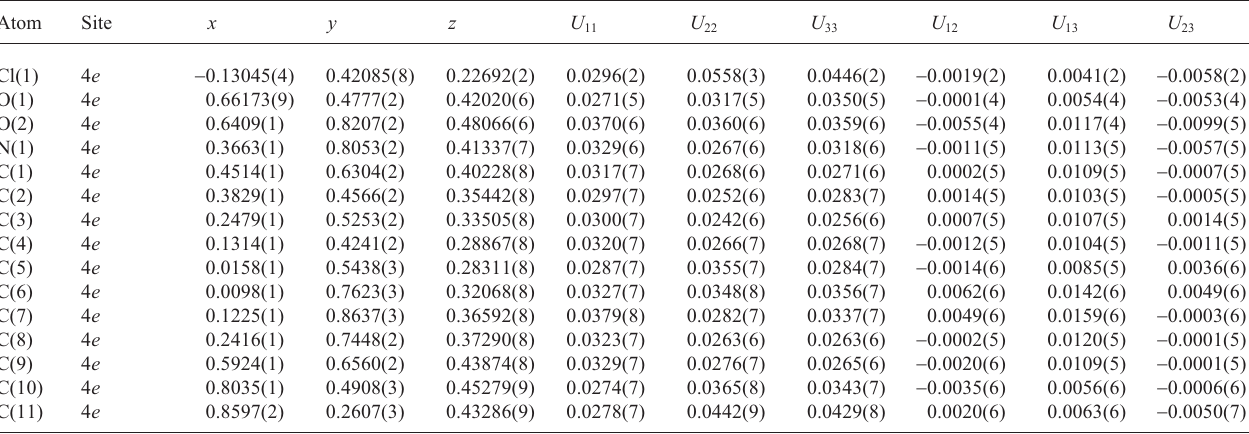
Table 3. Atomic coordinates and displacement parameters (in Å 2 )